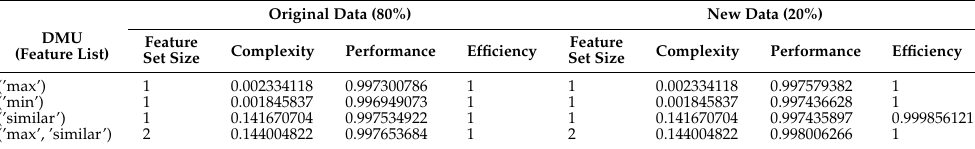
Table 3. Results of feature efficiency using DEA method.